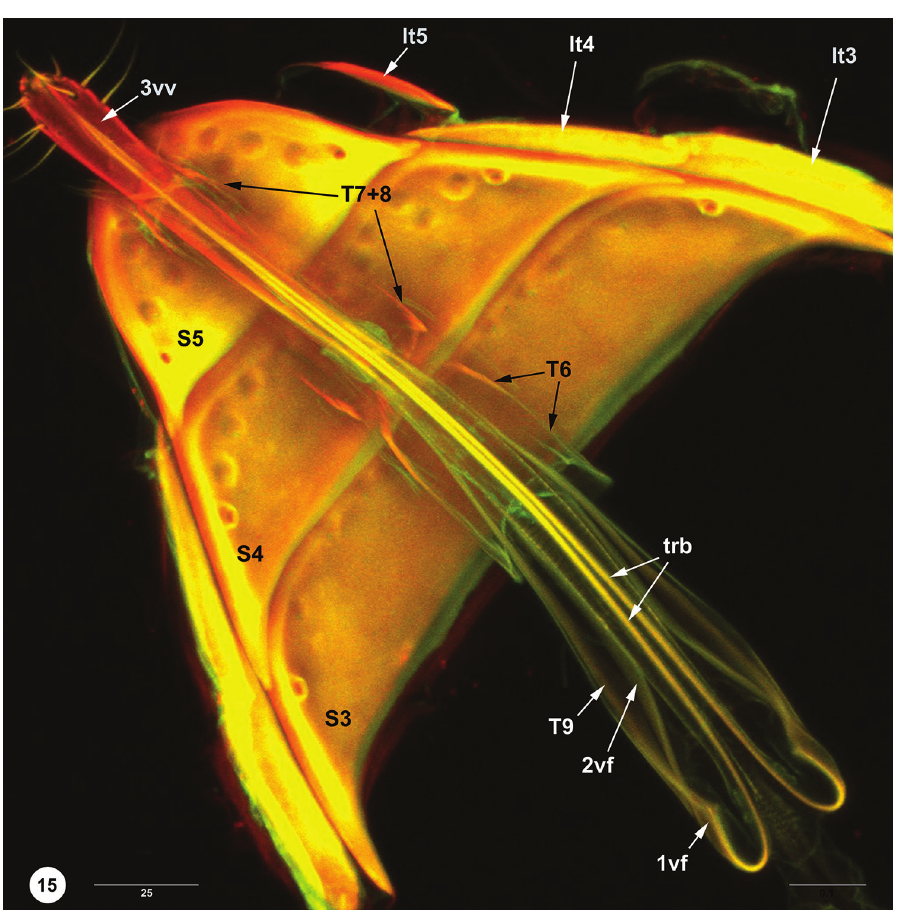
Figure 15. Gastrotrypes sp. female (USNMENT01197222). CLSM volume rendered maximum intensity projection micrograph showing the ovipositor system and distoventral metasomal tergites. Scale bar in